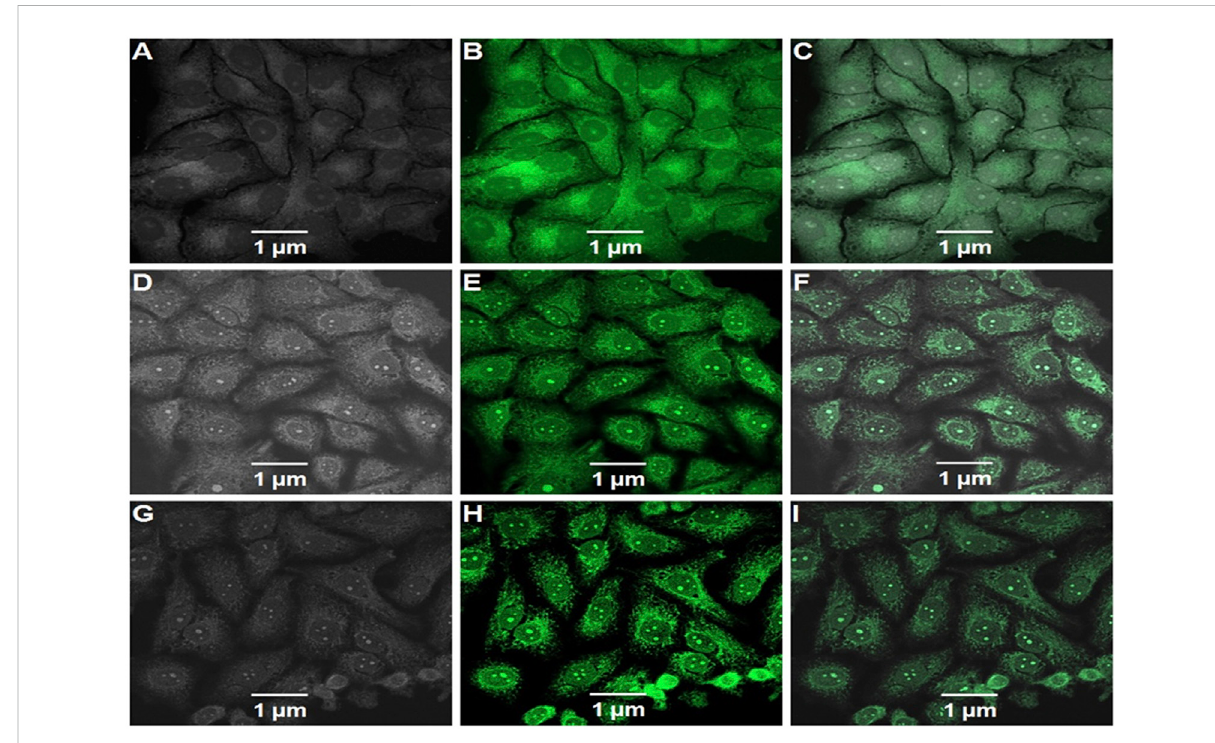
FIGURE 5 Confocal microscopic images of FITC-labeled DL (A – C) , FITC. labeled DLF (D – F) , and FITC labeled DLMF (G – I) showing the cellular uptake of nanoparticles in HepG2 cells. (A,D,G) Bright fi eld, (B,E,H) green fl uorescent channel and (C,F,I) overlay of channels.